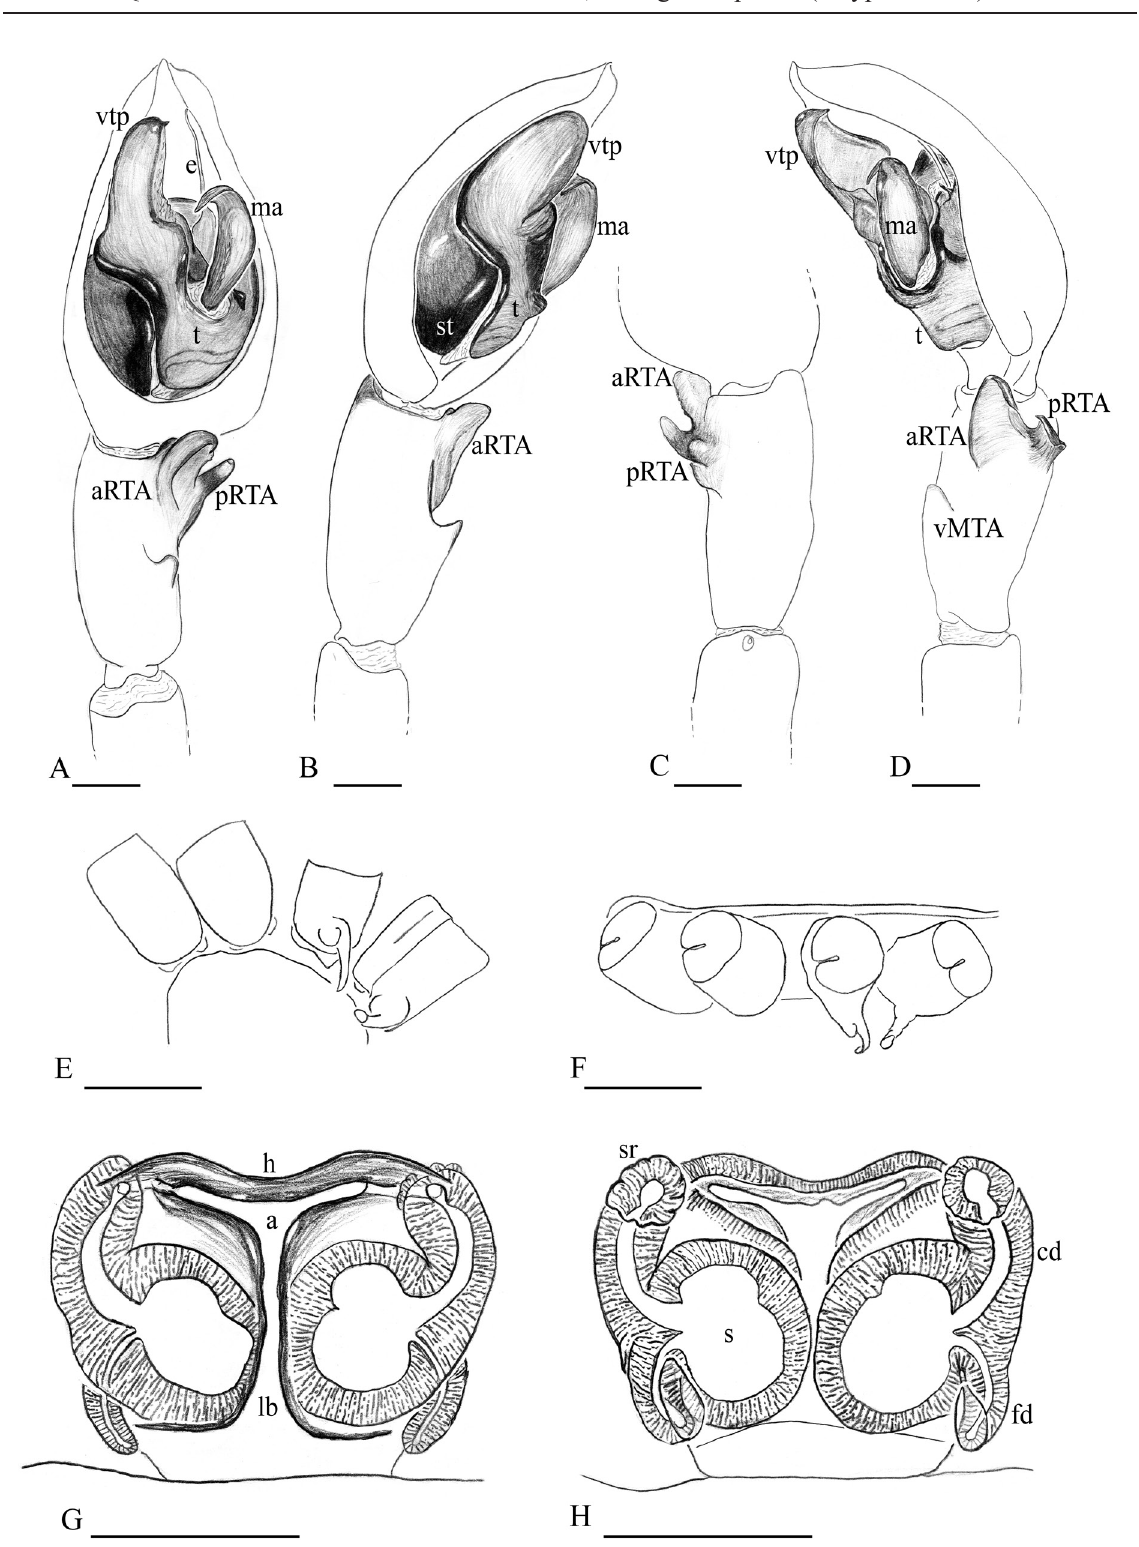
Fig. 33. Anyphaena miniducta sp. nov. A–F . Allotype, ♂ (CNAN-T01515). G–H . Paratype, ♀ (CNAN-T01561). A . Pedipalp, ventral view. B . Pedipalp, prolateral view. C . Pedipalp, dorsal view. D . Pedipalp, retrolateral view. E . Coxae, ventral view. F . Coxae, lateral view. G . Epigynum, ventral view. H . Epigynum, dorsal view. Scale bars: A–D, G–H = 0.2 mm; E–F = 1.0